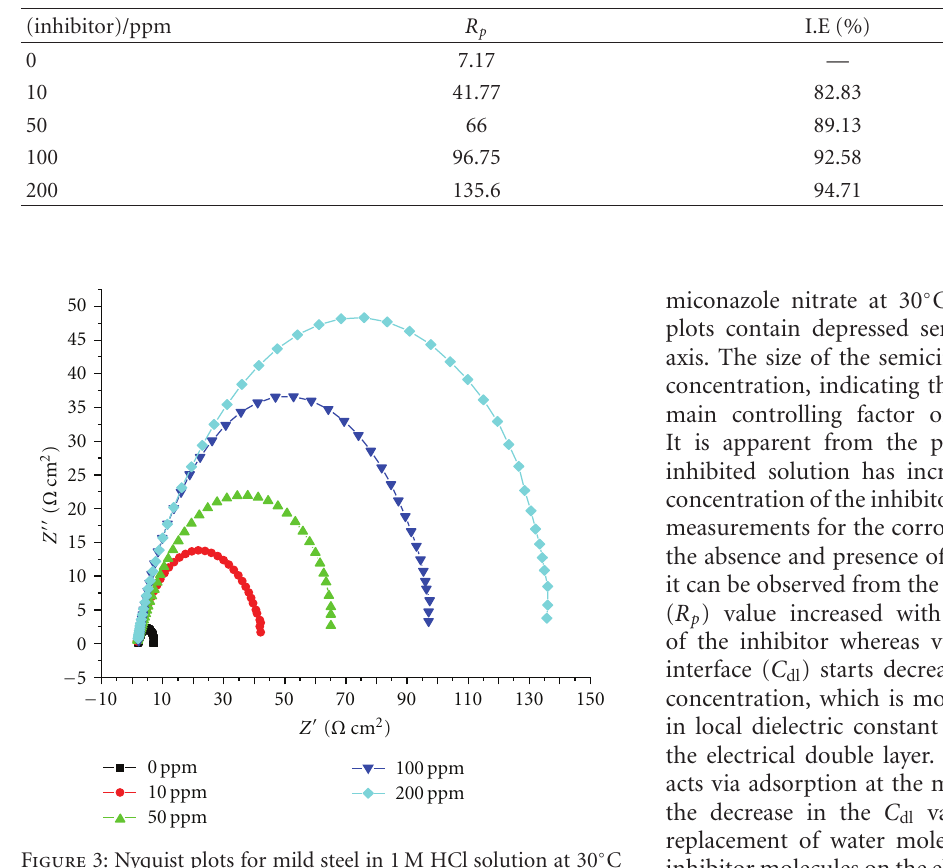
Table 2: AC impedance data of mild steel in 1M HCl solution at 30 ◦ C.